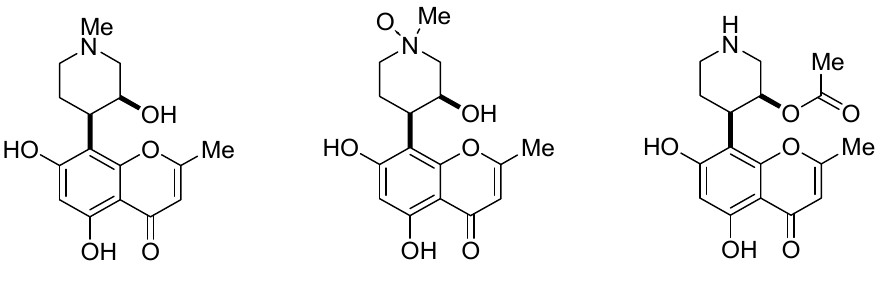
Figure 19. Piperidin-2-one-noreugenin ( 48 ) and N -methylpiperidin-2-one-noreugenin ( 49 ). O OOHHO Me O OOHHO Me MeNO HNO 49. N -Methylpiperidin-2-one-noreugenin 48. Piperidin-2-one-noreugenin Tubastraine [(3 R ,4 S )-4-[7-[(4-bromobenzoyl)oxy]-5-hydroxy-2-methyl-4-oxo-4 H